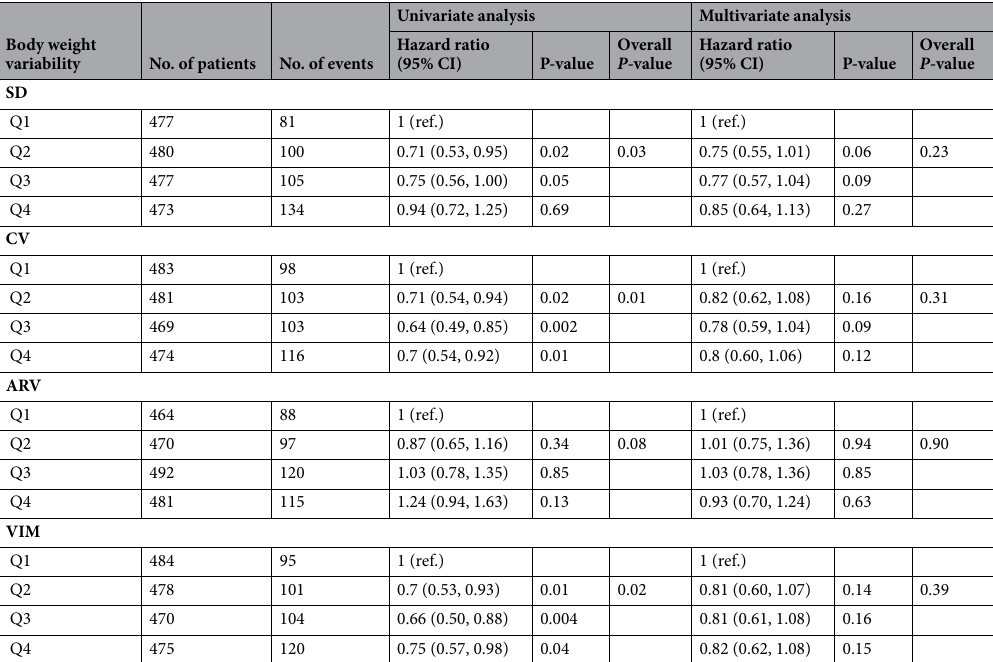
Table 2. The risk of incident NAFLD regarding level of body weight variability. Adjusted for age, sex, hypertension, diabetes, waist circumference, body mass index, triglyceride, high density cholesterol, total cholesterol, alanine transaminase, and number of measurements. NAFLD nonalcoholic fatty liver disease, CI confidence interval, SD standard deviation, CV coefficient of variation, ARV average real variability, VIM variability independent of mean, Q quartile.